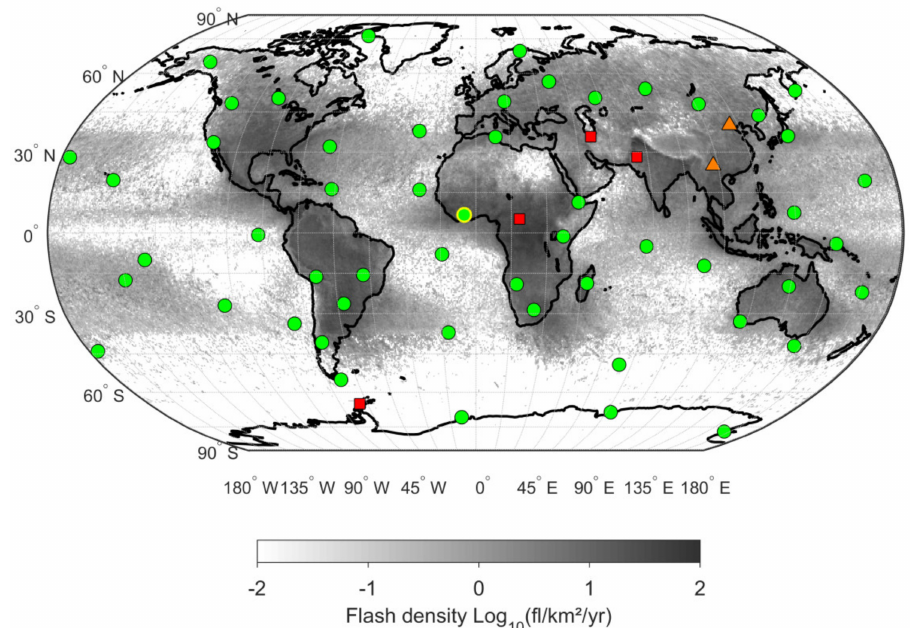
Figure 1. Location of the 60 infrasound stations of the IMS of the CTBT organization (circles) compared to the annual flash density measured from space by the LIS instrument on board the TRMM satellite (using the gridded lightning climatology dataset by Cecil et al. [22]). The color of the markers corresponds to the status of the IMS infrasound stations: green stands for certified, orange for installed or under construction and red for planned. IS17 is highlighted with a yellow circle, close to the map’s center. Note that one of the stations is not depicted here because its location is under